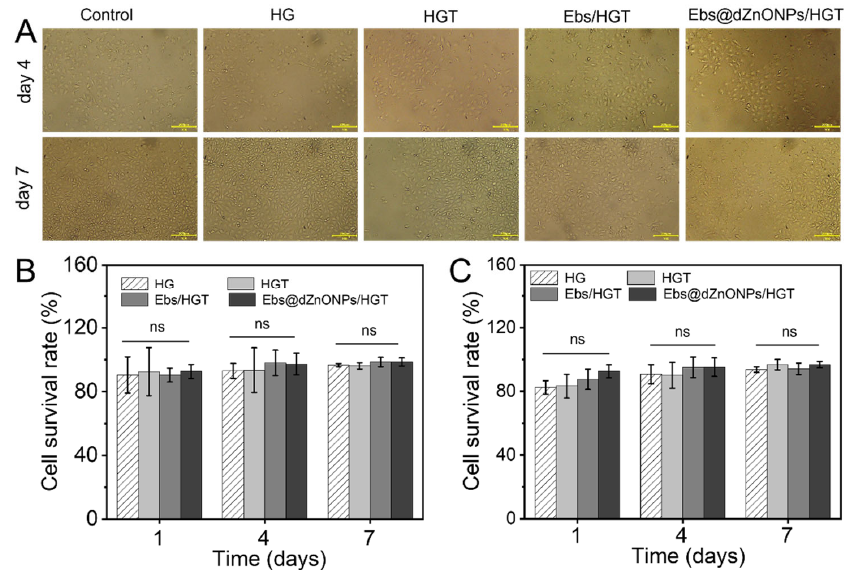
Figure 6. Cytocompatibility of hydrogels. ( A ) Morphology of HUVECs on day 4 and day 7; ( B ) Survival rates of HUVECs on days 1, 4, and 7; ( C ) Survival rates of L929 cells on days 1, 4, and 7. Data are presented as mean ± standard ( n = 3).